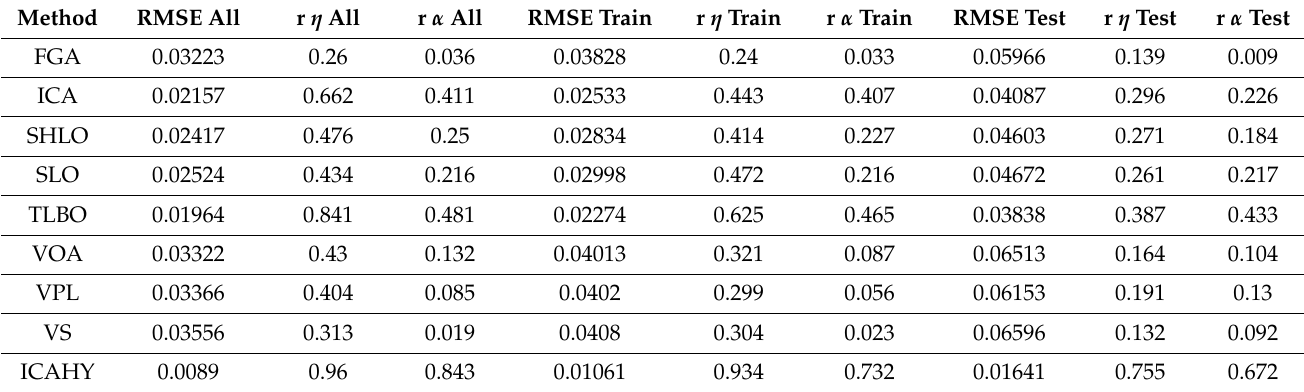
Table 2. RMSE and r metrics for the two outputs ( η , α ) resulting from applying the tested algorithms for optimizing the neural network architecture and weights using the entire dataset (“all”), the training split (“train”), and subsequently testing on the test split (“test”). The optimization was carried out for both outputs simultaneously. ICAHY is our method.